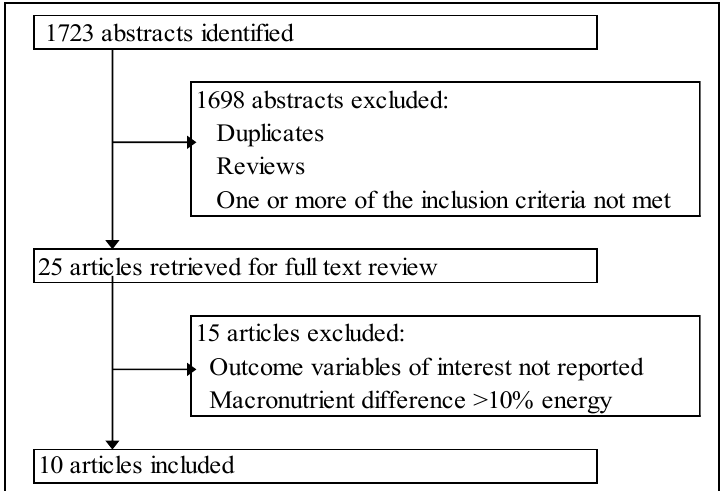
Figure 1 . Flow chart of study